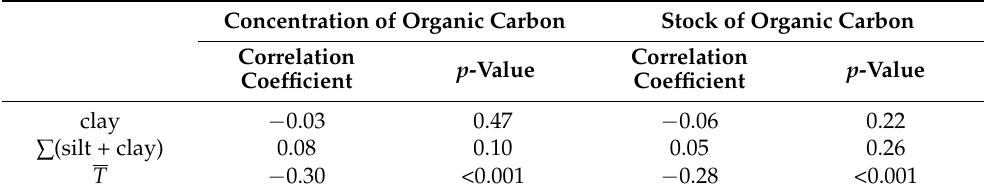
Table 3. Correlation between soil organic carbon concentrations (mean carbon concentration of upper 30 cm of the mineral soil) and soil organic carbon stocks (sum of organic carbon in upper 30 cm of the mineral soil) with the clay content (%), the sum of clay and silt (%), and the mean annual temperature ( T (°C)), average of the years 1960 to 1990), respectively. The analysis is based on data from 429 sites of the Austrian Forest Soil Survey 1989.